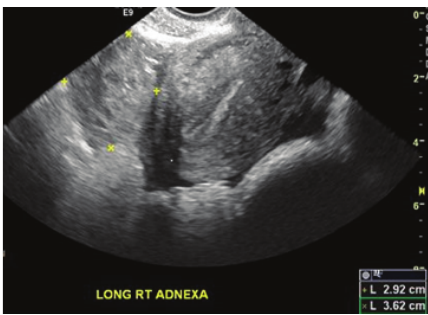
Figure 1: Mass-like area in the midline pelvis extending to the right of the midline measuring 2.9 × 3.8 × 3.6 cms.